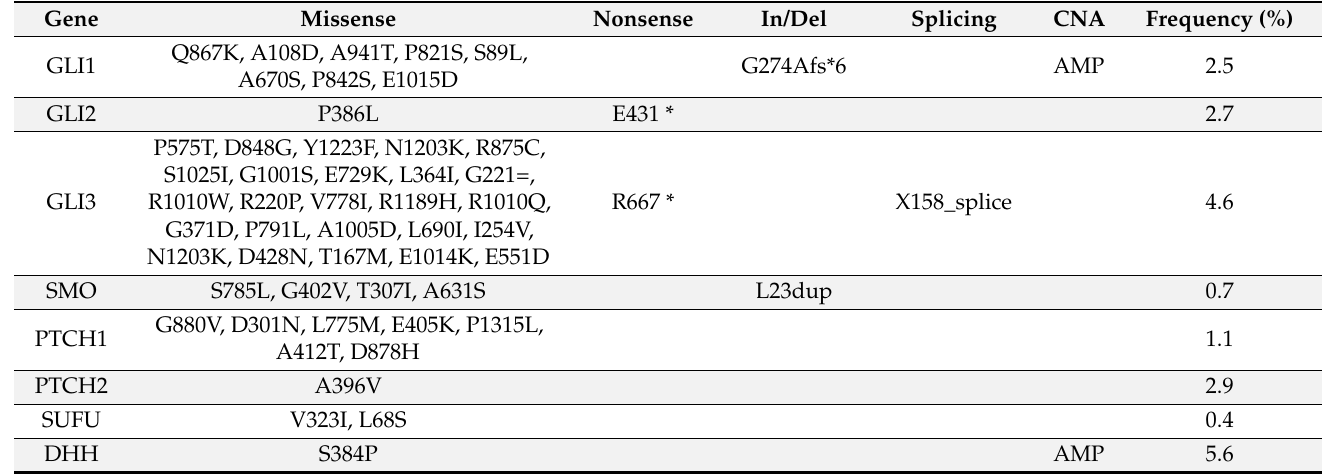
Table 1. Genetic alterations affecting Hedgehog signaling pathway in CCA